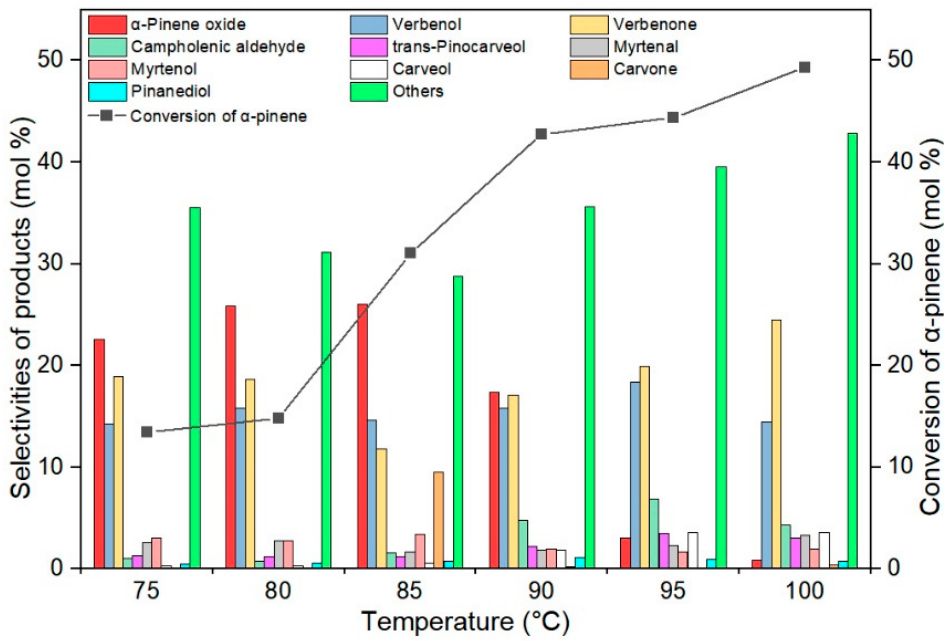
Figure 8. Influence of temperature on the conversion of α -pinene and selectivities of appropriate products in the oxidation of α -pinene over the TS-1_2 catalyst (catalyst content 2.5 wt%, reaction time 6 h), the figure shows the sum of the selectivities of the remaining by-products, which were formed with low selectivities.